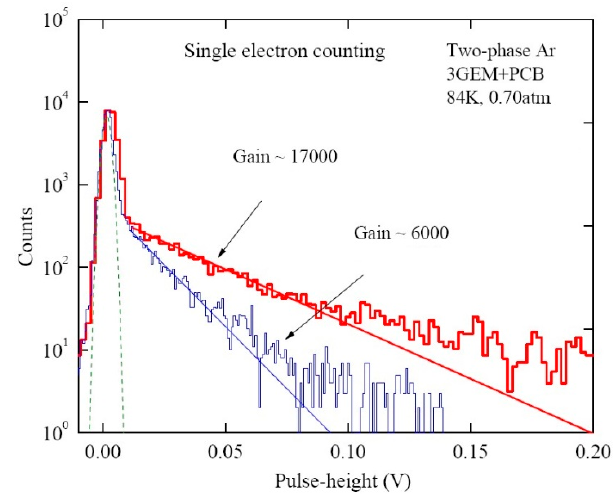
Figure 16. Pulse-height spectra in two-phase Ar detector with triple-GEM multiplier charge readout, operated in single electron counting mode with external trigger, at charge gains of 6000 and 17,000 [4,68]. The electronic noise spectrum (dashed line), corresponding to the equivalent noise charge of σ = 940 e − , is also shown. The multiplier active area was 2.8 × 2.8 cm 2 . The results were obtained for specially selected GEM foils resistant to discharges, to reach the highest gain. Note that the stable maximum gain of typical triple-GEM multipliers in two-phase Ar was somewhat lower: of about 5000.